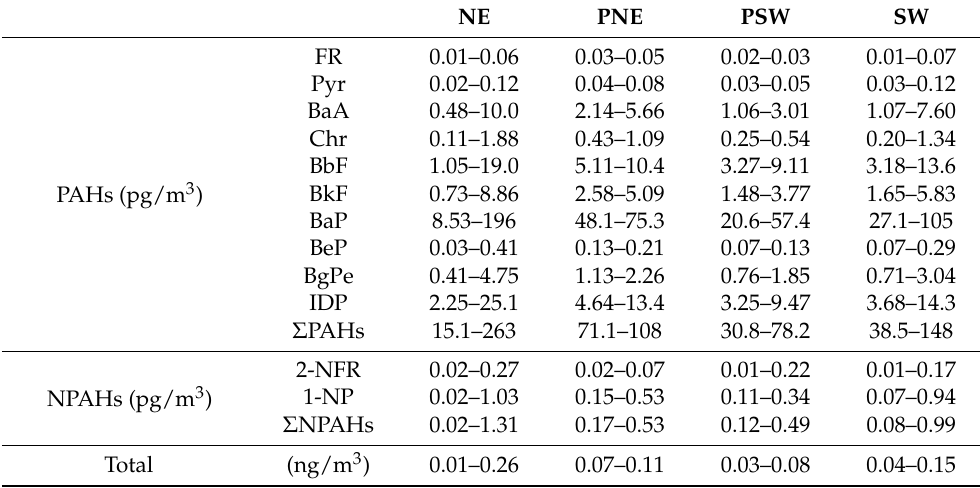
Table 2. The concentration range of ten PAHs and two NPAHs (except 6-NBaP and 2-NP) with respect to the toxic equivalent